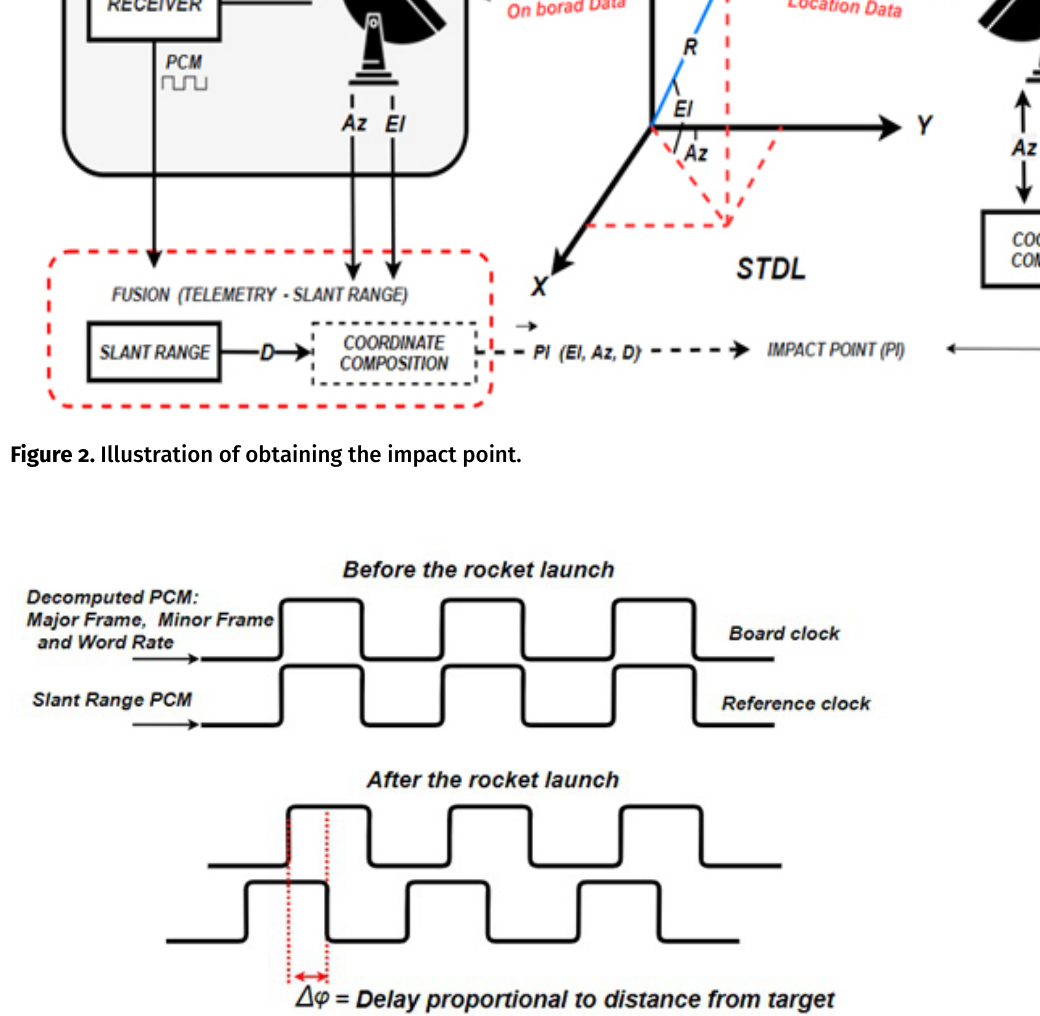
the demodulated PCM and the slant-range decice PCM are in phase; and second, after the launch, in which the rocket displacement begins, in this case, the phase comparator continuously measures the difference between in the signals generated Δ𝜙 which is subject to a propagation delay due to the radial distance. In which the phase or time difference is a direct indication of the payload position related to the telemetry antenna in tracking mode, enabling the vehicle to be located and the point of impact to be